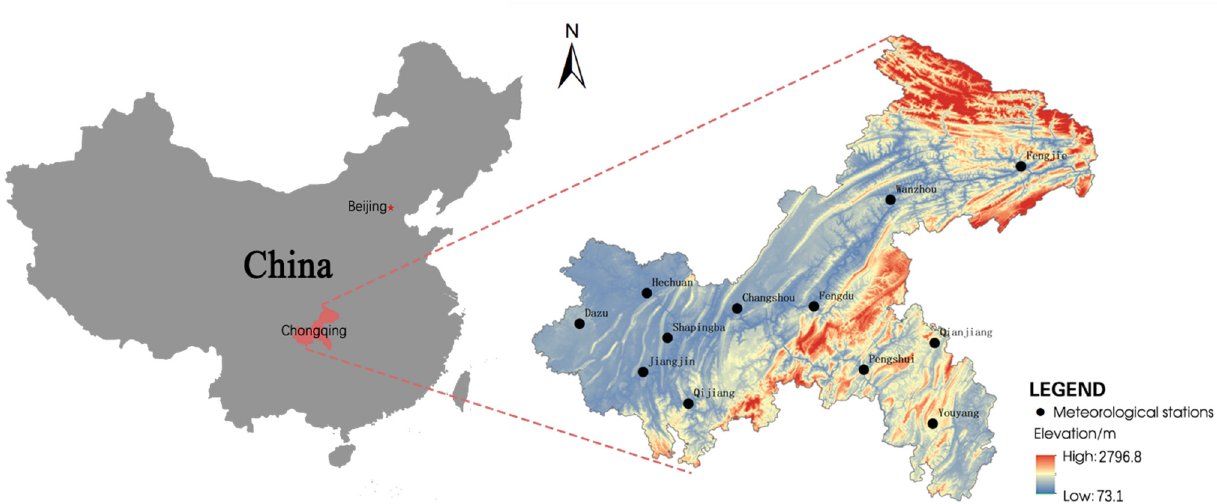
Figure 1. Location of Chongqing and Chongqing city elevation and meteorological station distribution (China Map Review Number: GS (2016) 1551). Table 1. Basic information of 12 weather stations in Chongqing.